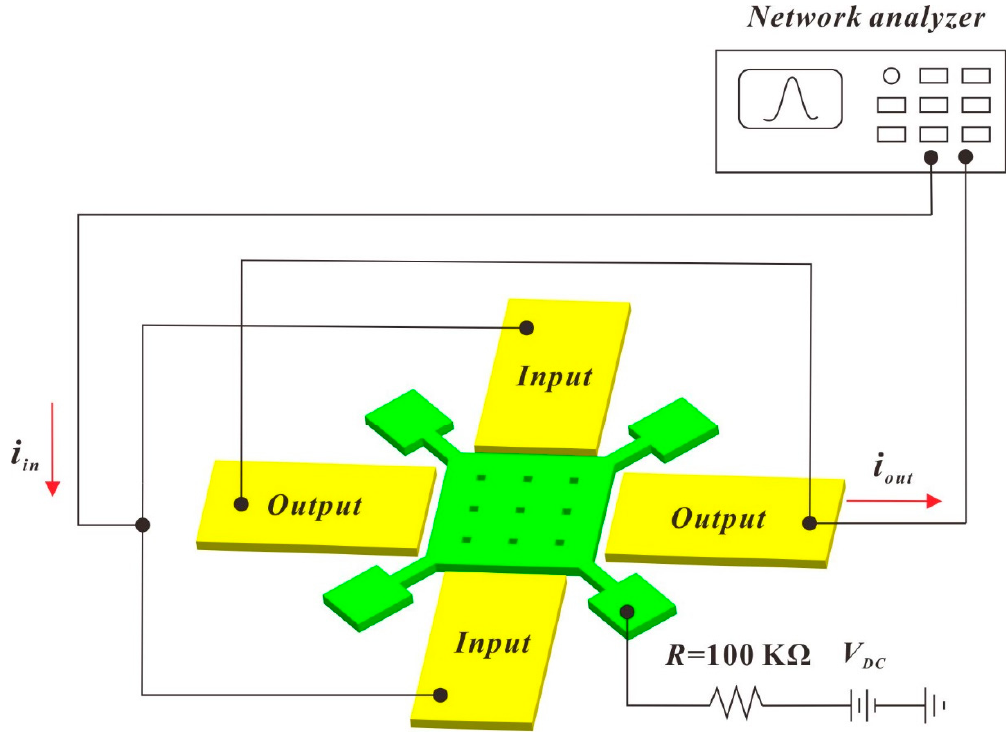
Figure 6. Measurement setup for the Lamé-mode resonator.